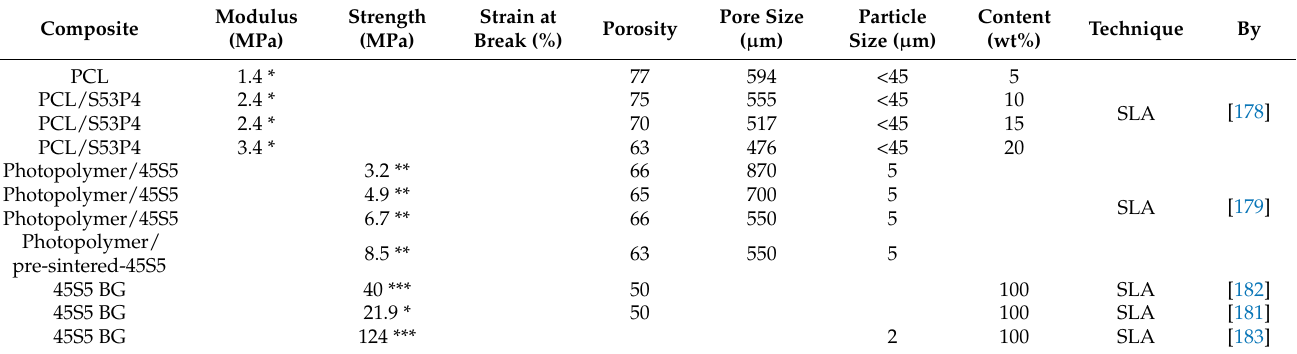
Table 8. Principal properties of SLS investigations. With * the compression, ** tensile and *** flexural modulus/strength (not filled cells mean no data).